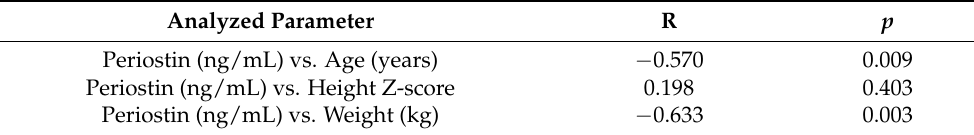
Table 4. Correlations of periostin concentration with clinical, biochemical parameters, blood pressure, and arterial damage parameters in 20 healthy